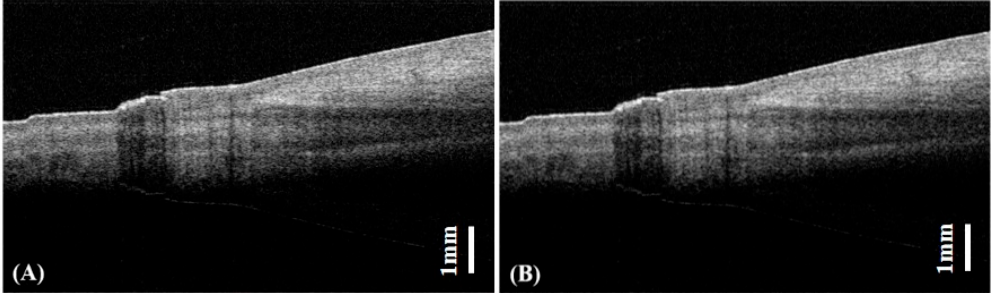
Figure 6. OCT images of fingernail reconstructed from logarithmic function ( A ) and lookup table ( B ) calculation.